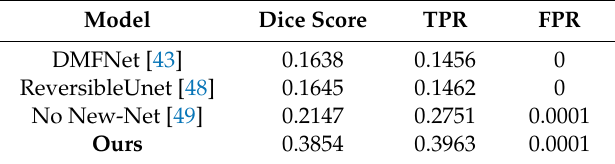
Figure 5. Qualitative comparison of different models for small tumor segmentation. ( a ) Input fluid attenuated inversion recovery (FLAIR) image. ( b ) Input T1 image and ( c ) ground truth images. ( d ) Results of our method. ( e ) Results of ReversibleUnet [48]. ( f ) Results of No New-Net [49]. ( g ) Results of DMFNet [43].